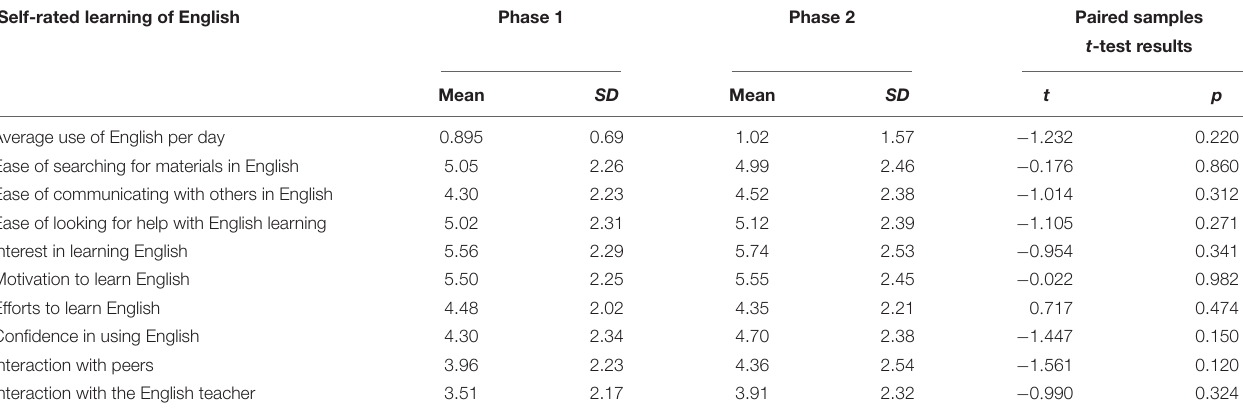
TABLE 1 | General information about the participants ( N =